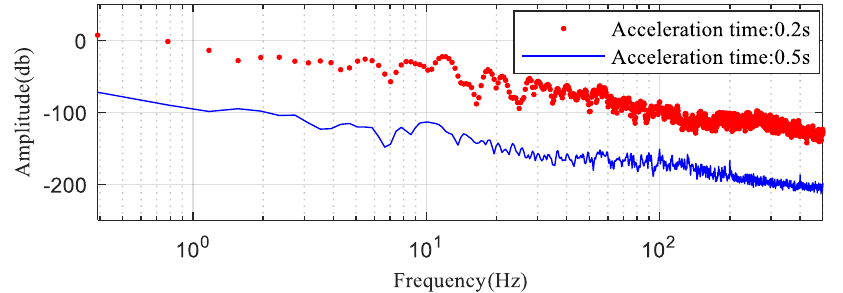
Figure 12. Power spectrum of the electromagnetic torque.